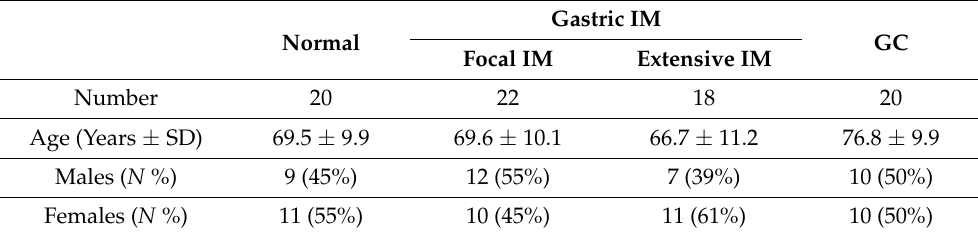
Table 1. Demographic details of the study